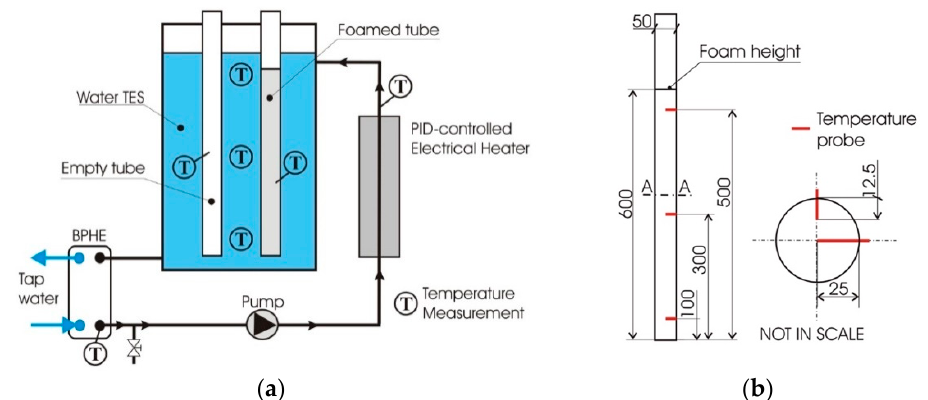
Figure 2. ( a ) Schematic of the experimental setup and ( b ) location of the temperature probes (in millimeters).